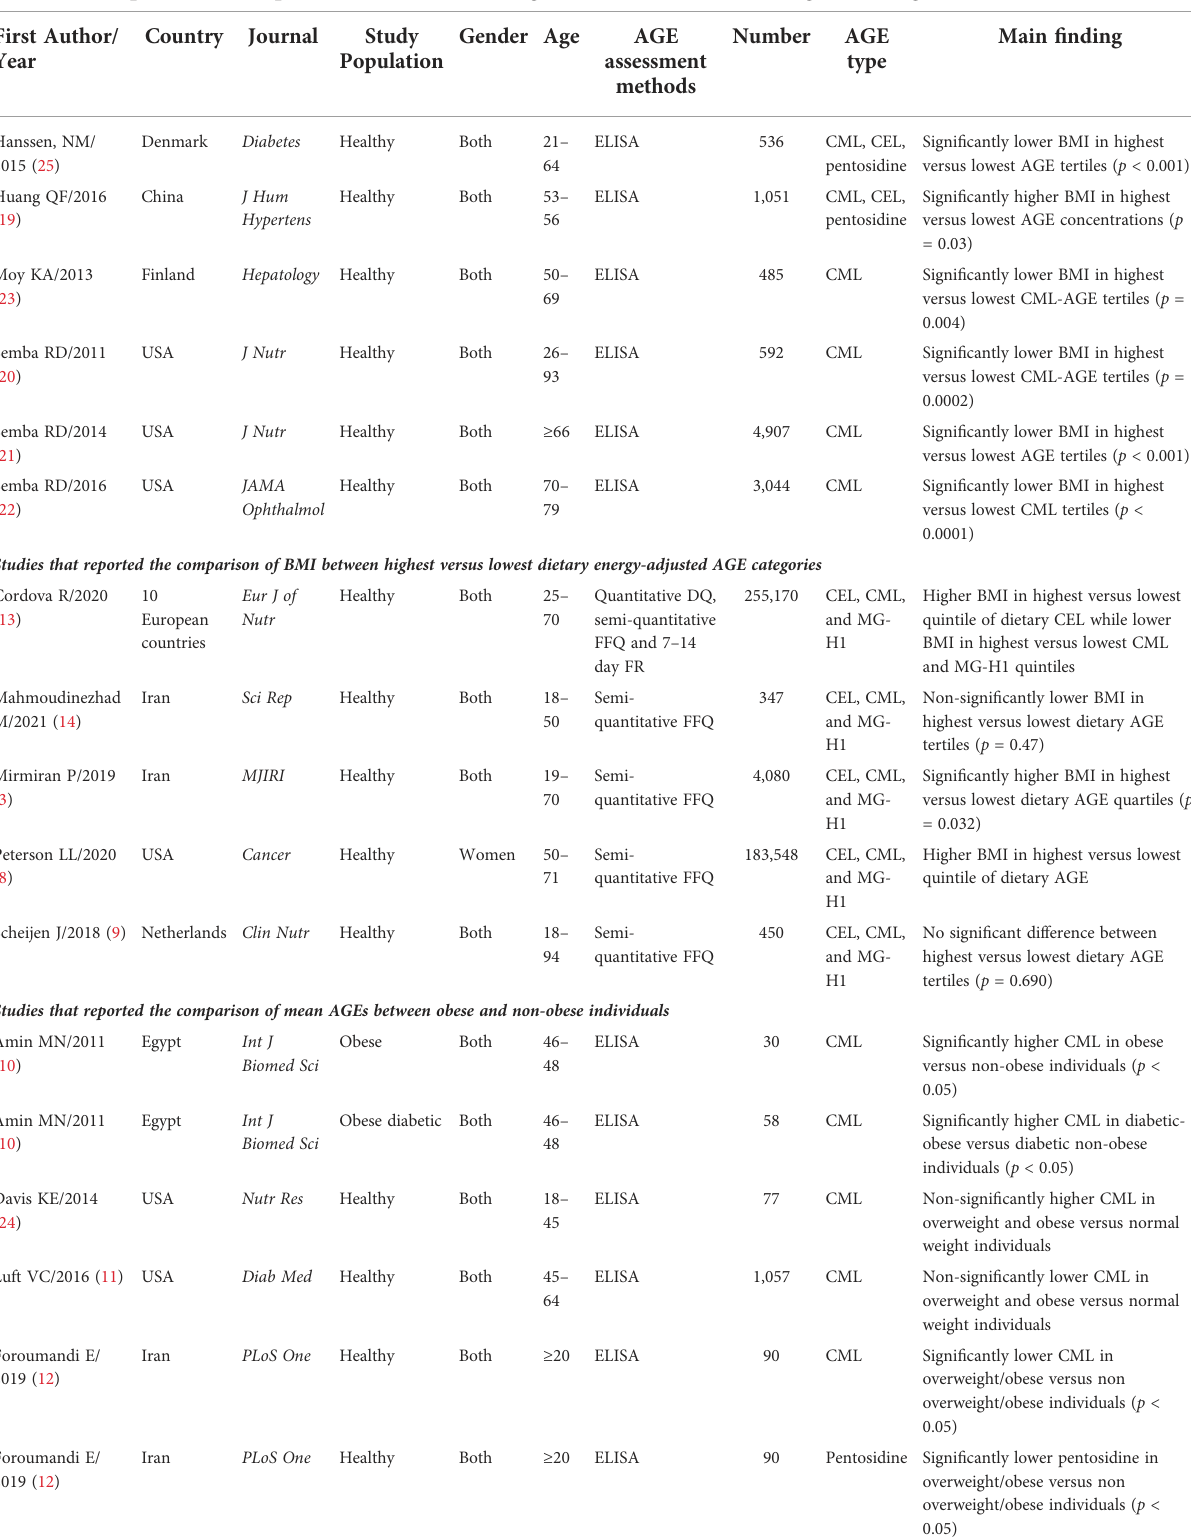
TABLE 3 Characteristics of studies included in the current systematic review. Studies that reported the comparison of BMI between highest versus lowest circulating AGE categories